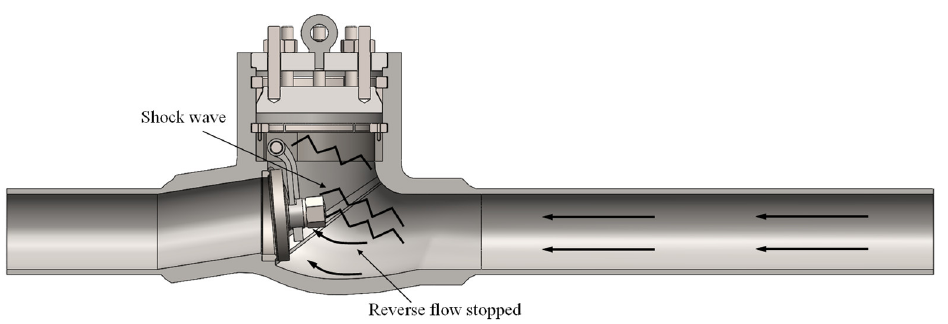
Figure 11. Molten salt swing check valve reverse flow state model.